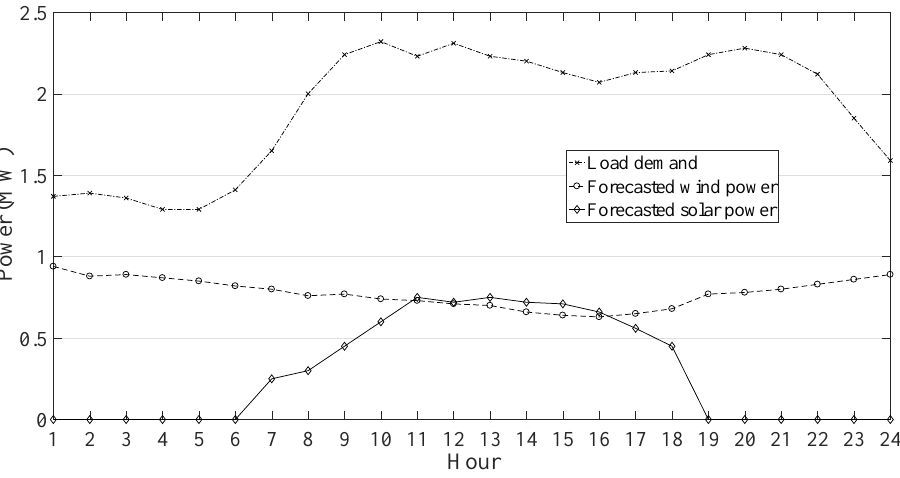
Figure 2. Hourly load demand, forecasted wind, and solar